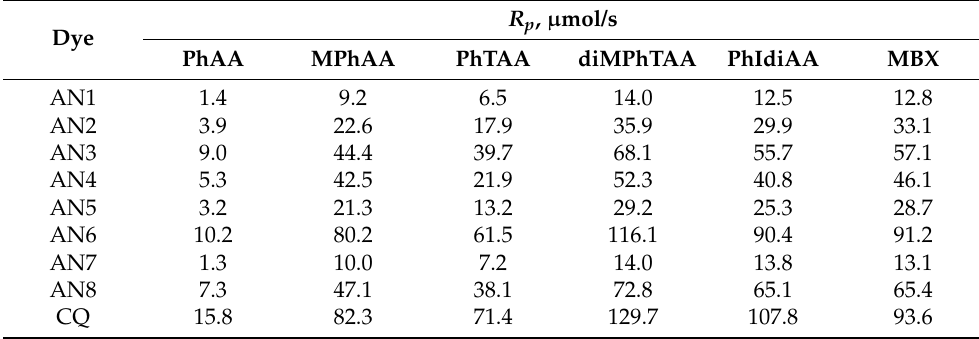
Figure 5. Family of kinetic curves recorded during the measurements of the heat flow emitted in the course of TMPTA polymerization photoinitiated by either ( a ) AN3 or ( b ) AN6 paired with different co-initiators (0.1 M); ■ — diMPhTAA, ▼ — PhIdiAA, ● — PhTAA, — MPhAA, — PhAA. The plots illustrate the effect of the electron donor on the initiation efficiency of TMPTA polymerization. The co-initiator concentration was 0.1 M, optical density of the dyes was 1.8 at an excitation wavelength (400 nm), light intensity of dental lamp was 30 mW/cm 2 . Table 2. Initial rate of photoinitiated polymerization ( R p ) for the tested photoredox